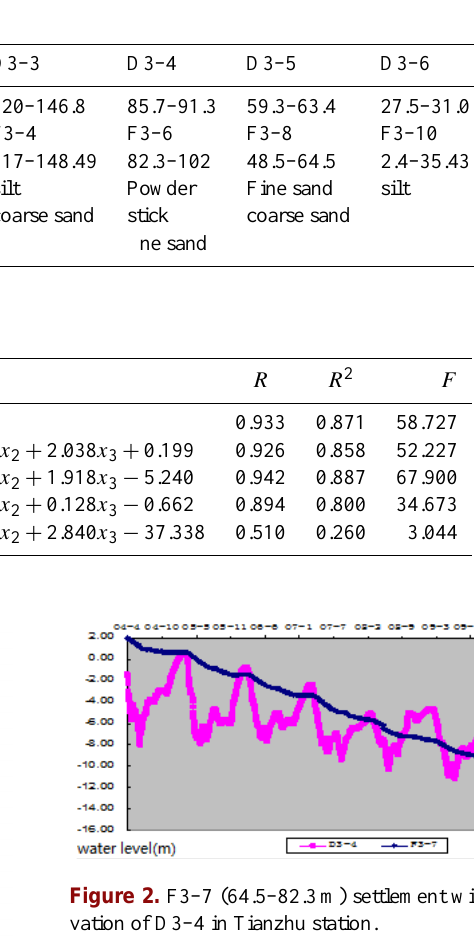
Table 1. Layer water level and settlement in Tianzhu station.